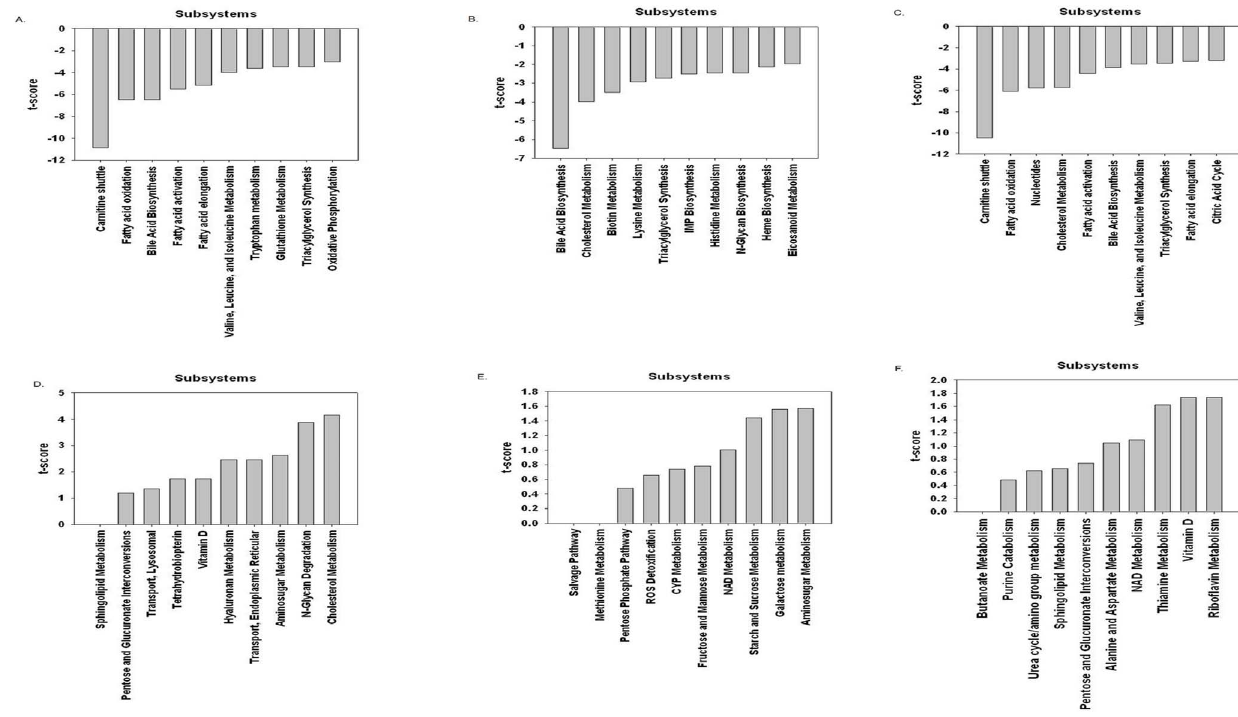
Figure 7. MCL multi-tissue model predictions on different pathways. (A), (B), and (C) represent downregulated pathways (subsystem) for adipose, liver, and skeletal muscle tissues respectively. (D), (E), and (F) represent upregulated pathways for adipose, liver, and skeletal muscle tissues respectively. They are organized by t-score; the more negative the t-score, the more down-regulated the subsystem and the more positive the t- score, the more up-regulated the